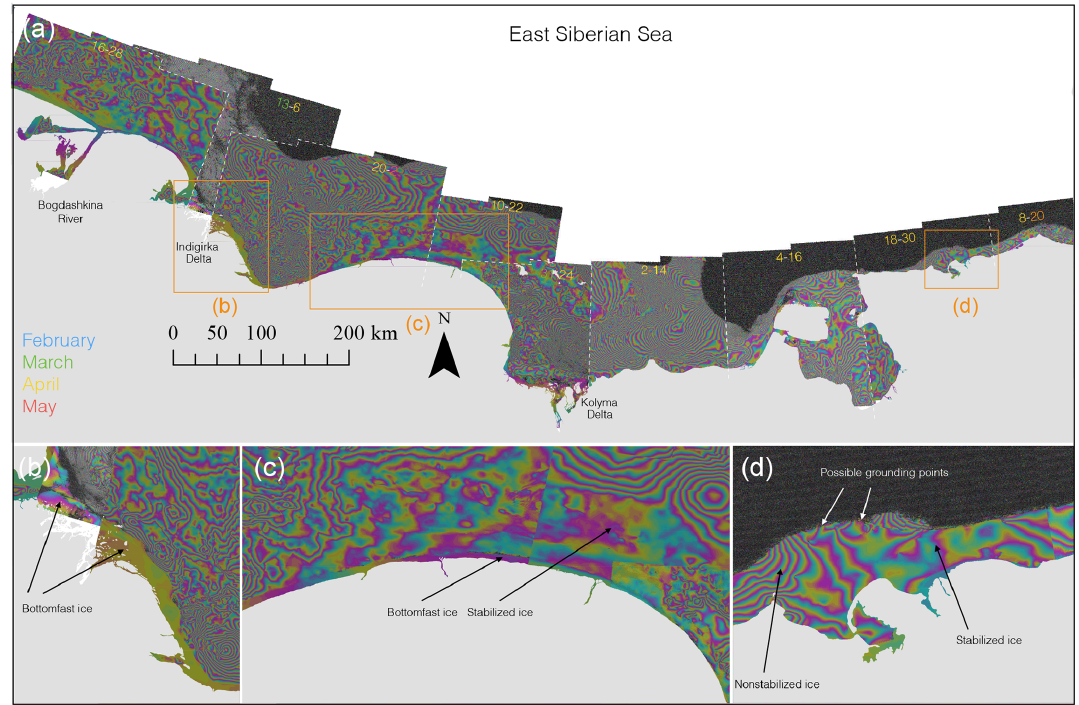
Figure 6. (a) Sentinel-1 interferograms derived from image pairs acquired over the East Siberian Sea between March and May, 2017. Numbers on images represent date ranges. The colors blue, green, yellow, and red signify the months of February–May. (b, c, d) Three enlarged areas identified in (a) are further discussed in the text. Table 2. Approximate area coverage of landfast ice (in thousand km 2 ). Area Bottomfast Stabilized Nonstabilized Total area of Area fraction: landfast ice nonstabilized/stabilized Beaufort Sea 2.5 35 29 67 0.83 Chukchi Sea 1.8 4.6 5.43 East Siberian Sea 5.1 1.78 Laptev Sea 205 1.72 Kara Sea 2.6 56